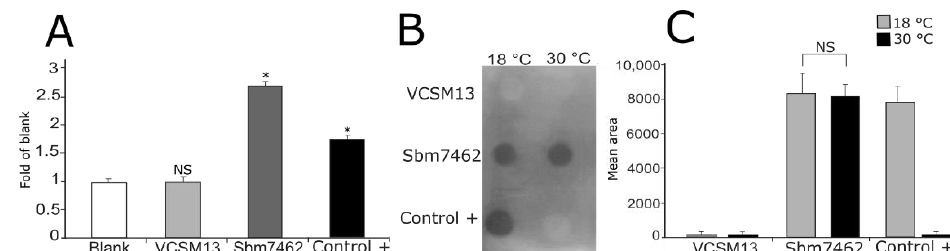
Figure 2. Phage characterization. Expression of recombinant antigens on the surface of bacteriophage M13. ( A ) Phage ELISA. Recombinant phage expressing Sbm7462 antigen was probed in a direct ELISA assay using anti-His antibodies. ( B ) Dot blots of bacteriophages expressing antigens. Expression of antigens on phage surface at different temperatures of a 17 h culture (18 °C, 30 °C). VCSM13 phage as negative control for phage samples (1 × 10 11 PFU per dot). SBm7462 phage-based vaccine at 1 × 10 11 plaque-forming units (PFU) per dot. Sbm7462 represents the antigen displayed on phage. Control + is represented by a phage expressing a tetanus toxin Fab produced through the pComb3x phagemid vector. Samples were probed using mouse anti-His-Tag. ( C ) Densitometric analysis of the dot blots. * p -value < 0.05, NS—not significant.